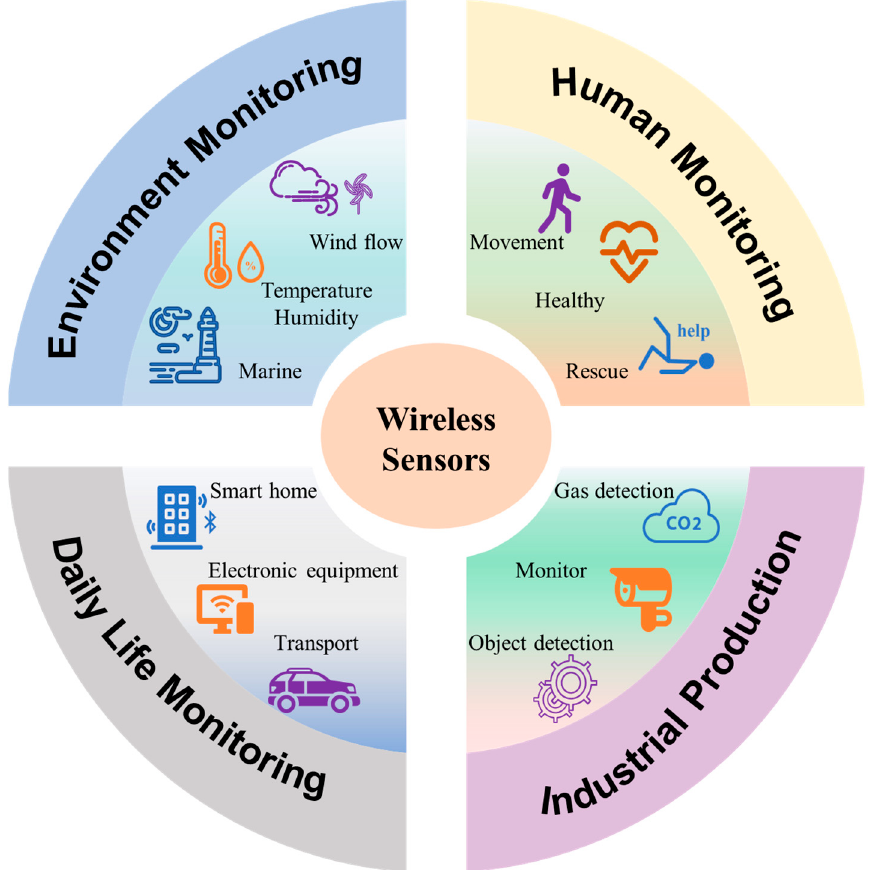
Figure 1. Schematic illustration of wireless sensors for environmental monitoring, human monitoring, industrial production, and daily life.